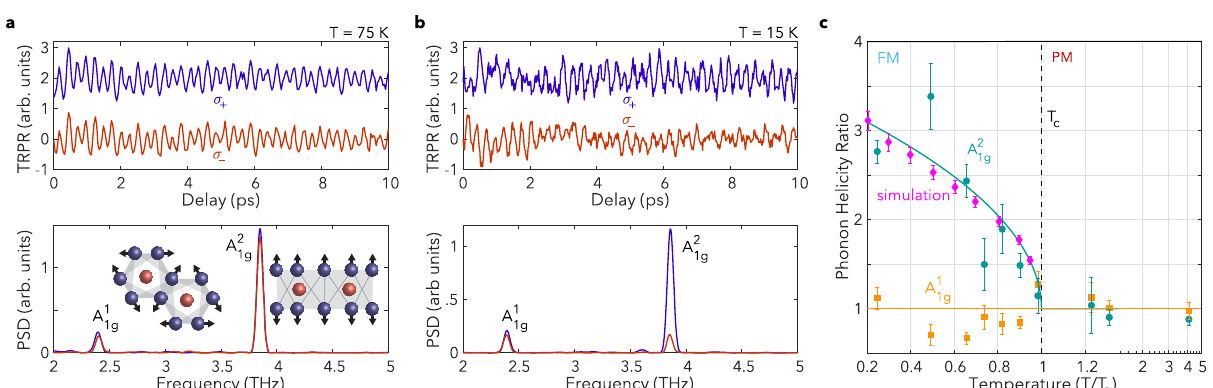
Fig. 3 Coherent spin-coupled phonon dynamics as a function of temperature. Oscillations in the time domain signals (upper panel) after subtraction of the demagnetization background, under σ þ (blue) and σ (cid:3) (red) pumping, and their corresponding power spectral densities (PSDs, lower panel) at a T ¼ 75K and b T ¼ 15K. The inset of a shows a schematic of the eigenvectors associated with the two phonon modes. c The σ þ = σ (cid:3) ratio of the integrated Fourier transform peaks of the measured signal at the A 1 frequency (pink) vs. normalized temperature. The solid green line is a fi t using a FM order-parameter-like function / ratio at the A 2 1g orange line is a guide to the eye. Error bars for the experimental data in c were obtained from a bootstrap